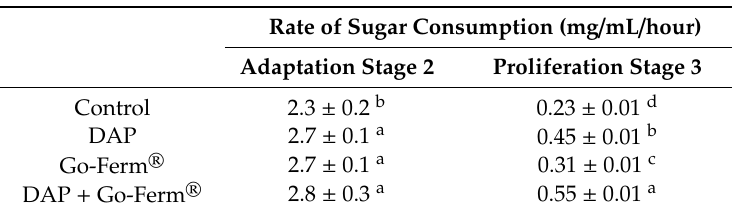
Table 3. Rate of sugar consumption during yeast acclimatization calculated from the di ff erence in time and specific gravity at the start and end of adaptation stage 2 and proliferation stage 3, respectively. Treatments were replicated ( n = 4) and are represented as the mean ± standard deviation. Lower case letters indicate statistical di ff erences in sugar consumption rates between treatments determined by ANOVA with mean separation by Fisher’s Protected